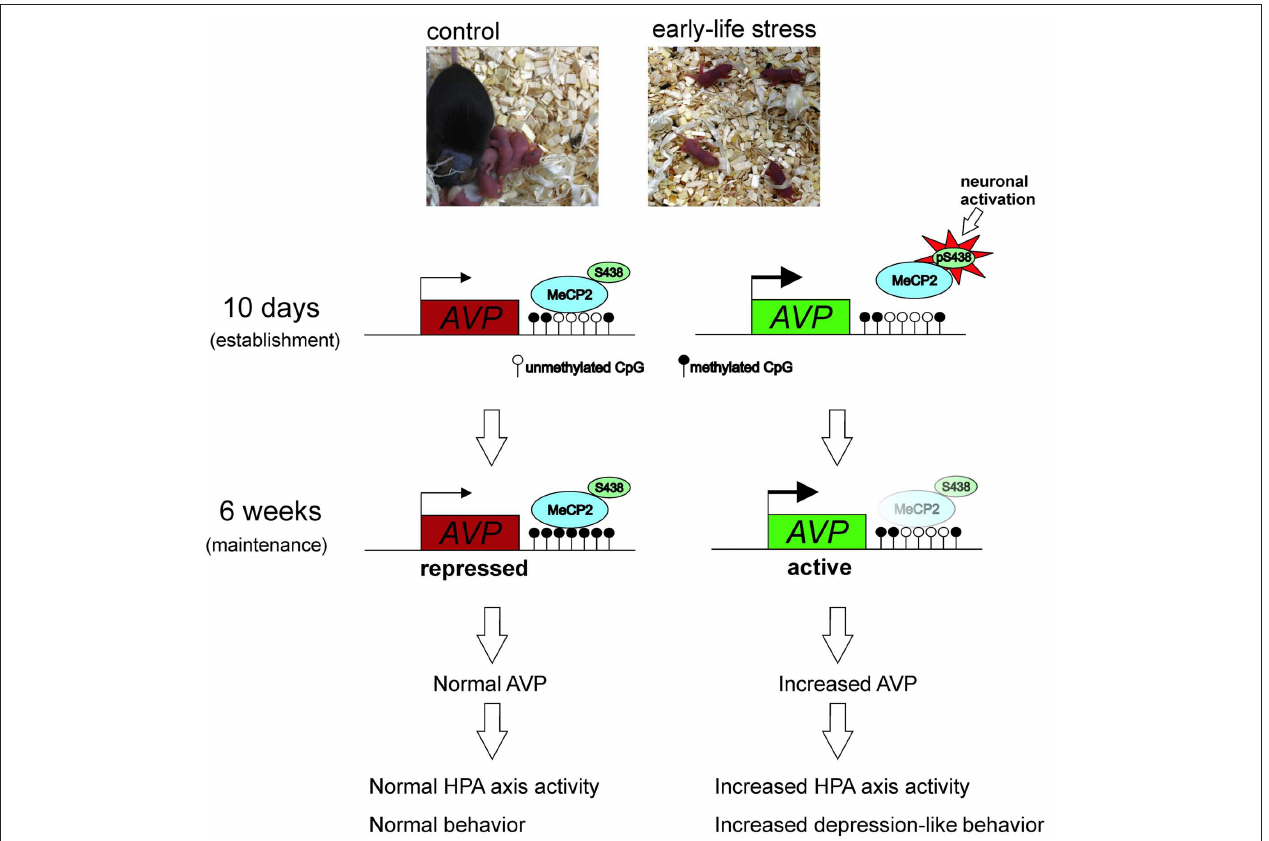
Figure 4 | experience-dependent activation of neurons in the PVN during early life inhibits MeCP2 binding to and repressing the AVP gene in stressed mice. This further favors DNA hypomethylation underpinning reduced MeCP2 occupancy at the AVP enhancer and maintaining epigenetic control of AVP expression into later